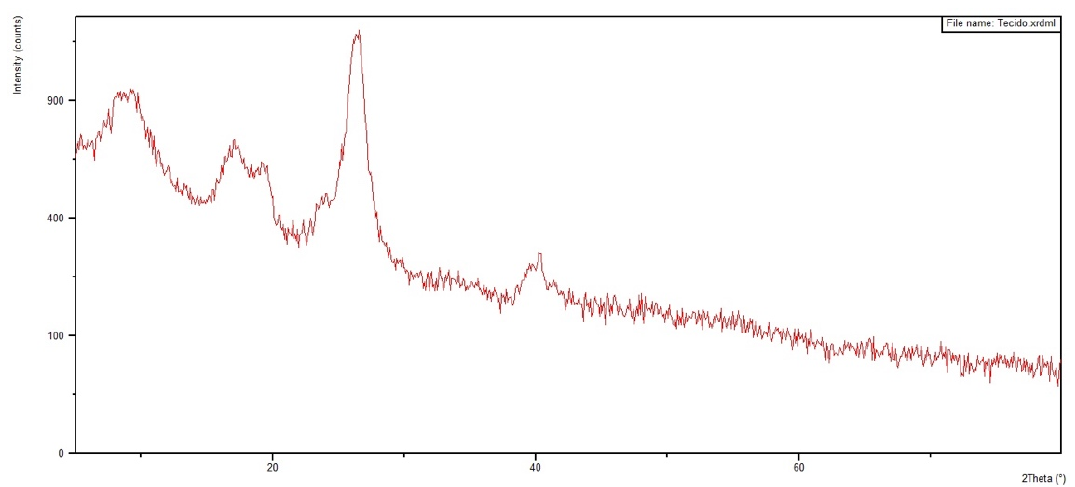
Figure 15. Diffractogram of the plain ramie fabric.